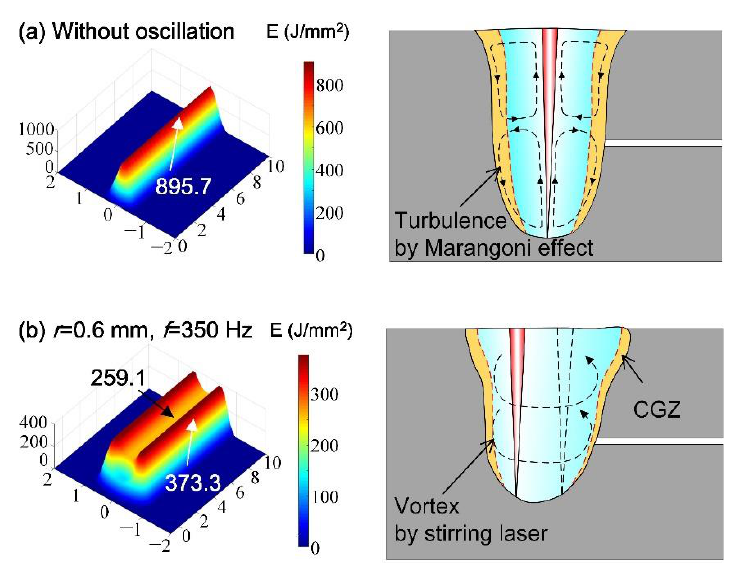
Figure 6. Schematic of the influence of beam oscillation on melt flow, ( a ) without oscillation, ( b ) r = 0.6 mm, f = 350 Hz.